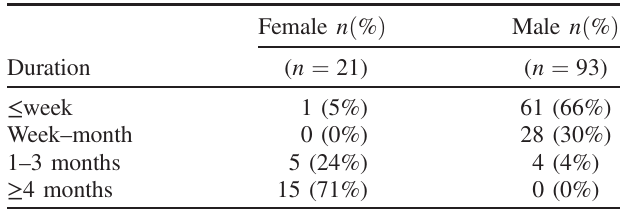
TABLE III. Results of survey for the following question: What is the duration of the maternity leave you took after the birth of your last child? χ 2 ¼ 92 . 67 , P < 0 . 00001 .